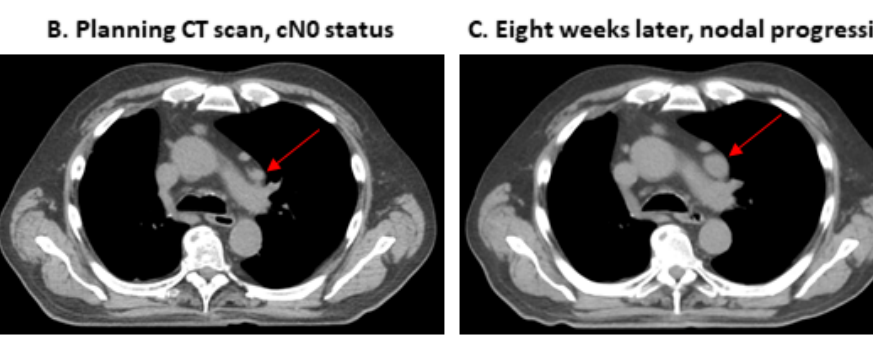
Figure 5 . Clinical example of a patient without positron emission tomography/computed tomography staging and subsequent rapid regional progression. Male patient diagnosed with stage IA2 non-small cell lung cancer of the left upper lobe. The patient was staged with conventional imaging (computed tomography scan of the upper and lower body, cranial magnetic resonance imaging and bronchoscopy, image ( B ) shows the initial status). The patient was treated with 55 Gy in 5 fractions (prescribed to the 80% isodose; image ( A ) shows the dose from 55 Gy [blue] to 68.75 Gy [red]). A CT-scan 2 months later (image ( C )) showed good response of the primary tumor, but revealed the progression of a mediastinal lymph node (growth from 1.5 cm × 0.9 cm to 2.3 × 1.5 cm, red arrows in images ( B , C )).